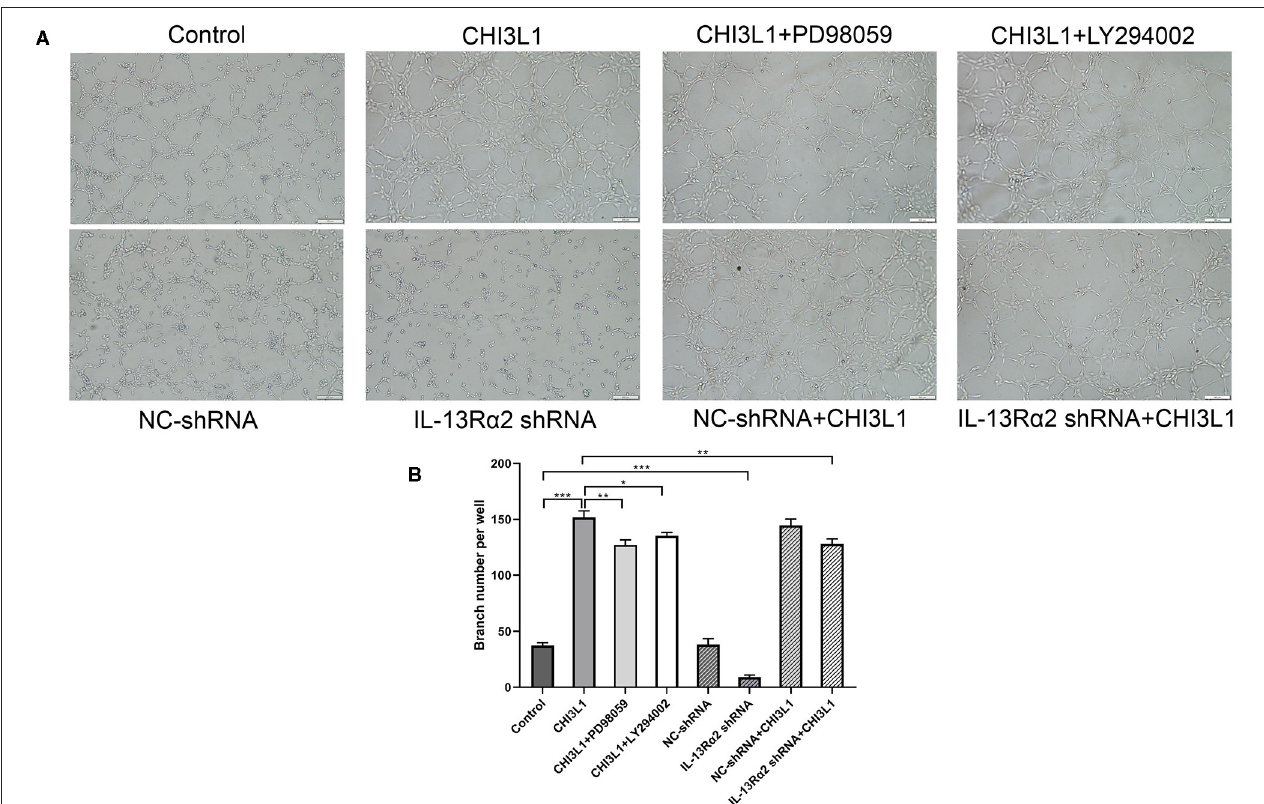
FIGURE 5 | CHI3L1 prompted angiogenesis of HUVECs in vitro (magnification 100 × ). Representative images of angiogenesis of HUVECs. IL-13R α 2 shRNA, MEK (PD98059) inhibitor, and PI3K (LY294002) inhibitor inhibited the angiogenesis capacity stimulated with CHI3L1 (A) . The qualification of branch points number was calculated (B) . Data were presented as mean ± SD ( n = 3 per group). * p < 0.05, ** p < 0.01, and *** p <